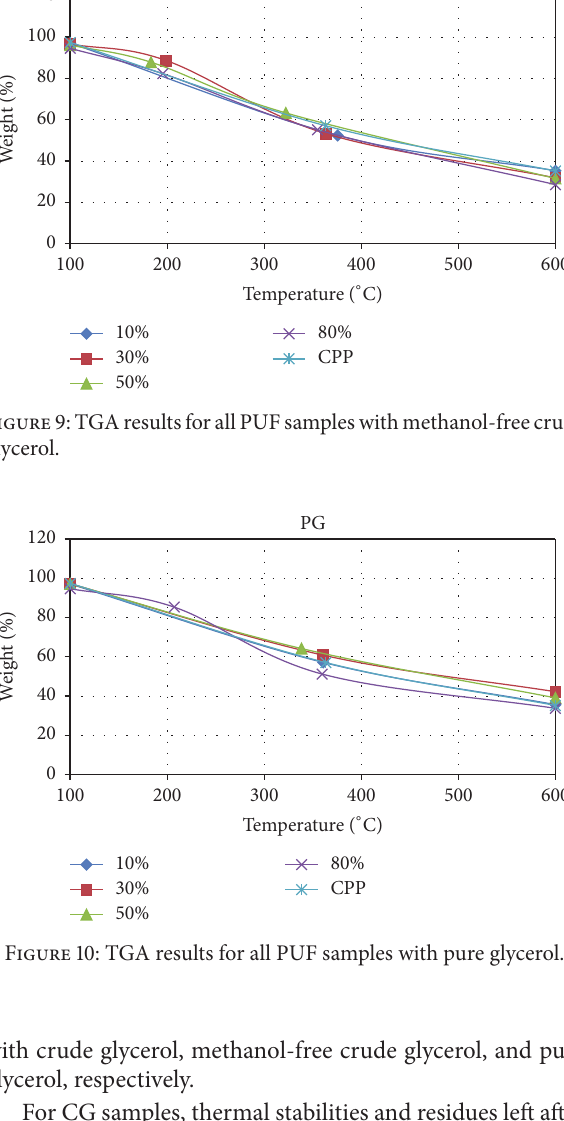
values increased with polyglycerol content increased, 0,0258 ± 0,0007 and 0,0326 ± 0,0006 W/m ⋅ K, respectively. Thermal conductivity values of all samples, with CG, MFCG, and PG, were higher than commercial PUF.